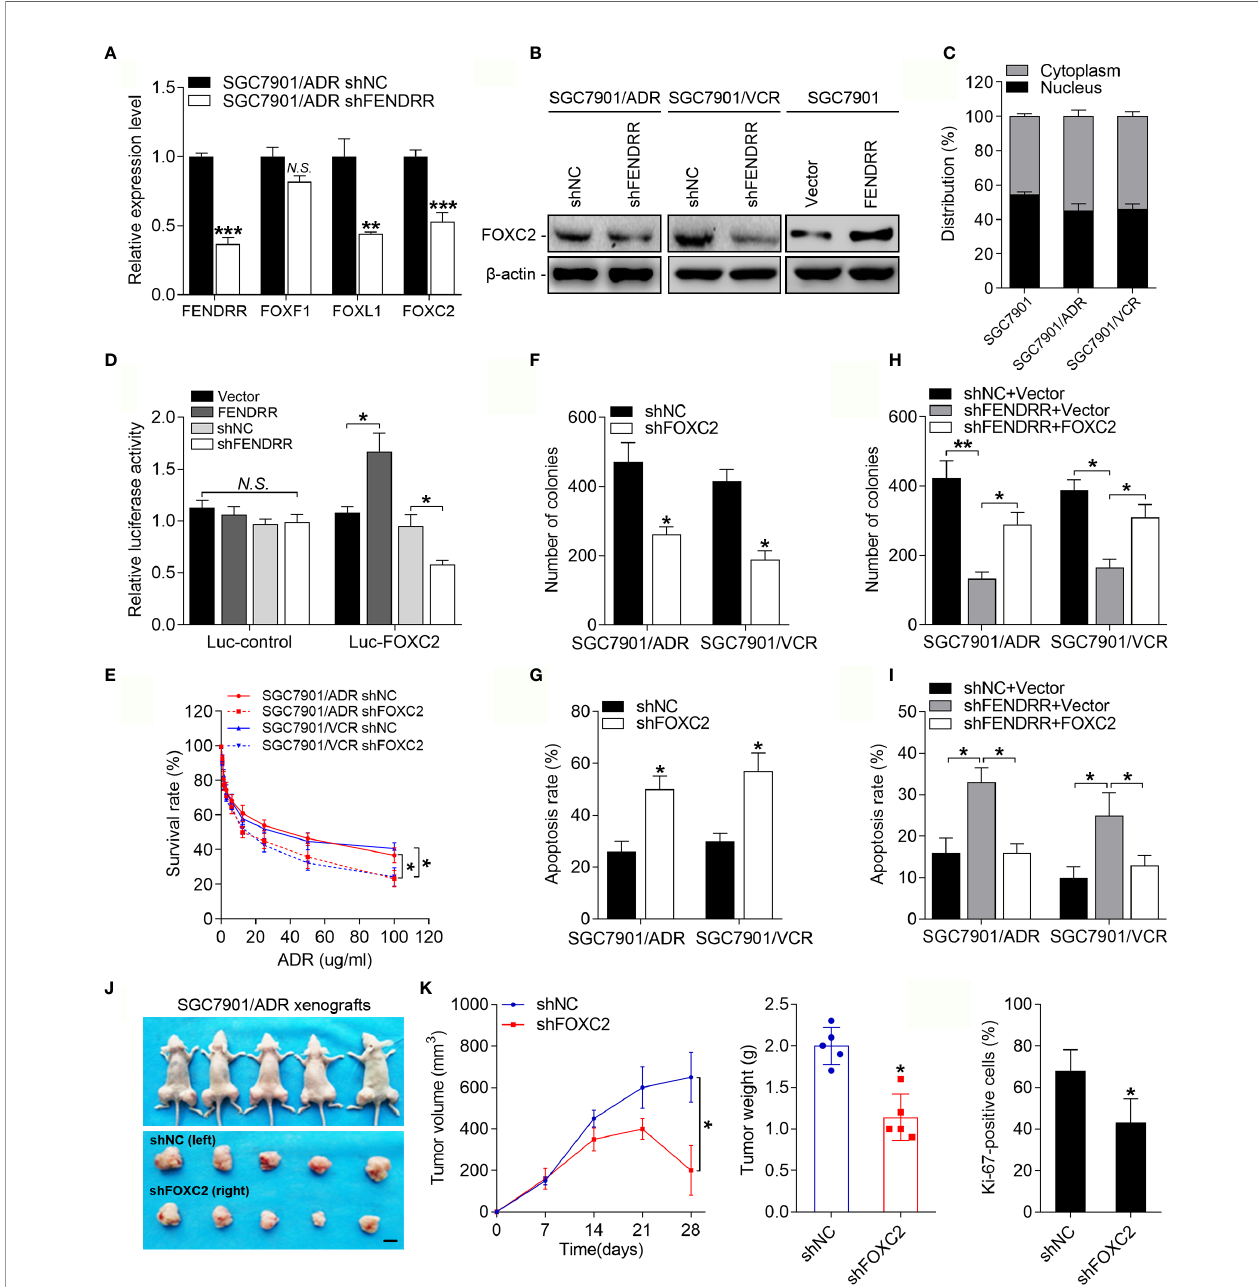
FIGURE 3 | FENDRR-regulated FOXC2 overexpression promotes GC drug resistance (A) qRT-PCR analysis of FENDRR, FOXF1, FOXL1 and FOXC2 expression in SGC7901/ADR cells infected with FENDRR shRNA or negative controls. (B) Western blot analysis of FOXC2 expression in SGC7901/ADR and SGC7901/VCR cells infected with FENDRR shRNA and in SGC7901 cells transfected with FENDRR vectors and the corresponding negative controls. (C) Expression levels of FENDRR in the nucleus and cytoplasm of the indicated cells was measured by qPCR. U1 and GAPDH were used as nuclear and cytoplasmic controls, respectively. (D) HEK- 293 cells were transfected with FOXC2 luciferase reporter constructs and FENDRR-expressing vectors or shRNA and the corresponding negative controls. Luciferase activity values were measured and analyzed. Luciferase values are normalized to empty vector control values. (E) Survival of indicated cells after step-up concentration of ADR treatment for 72 h was evaluated using the CCK-8 assay. (F, G) Colony formation assay with the indicated cells treated with ADR (F) and the apoptotic rate of the indicated cells treated with 5-FU (G) are shown. (H, I) Colony formation assay (H) and apoptosis assay (I) of SGC7901/ADR and SGC7901/ VCR cells infected with LV-shFENDRR with FOXC2 vector or control vector after ADR and 5-FU treatment, respectively. (J) LV-shFOXC2-infected cells were transplanted into the right fl ank of nude mice, and the corresponding control cells were transplanted into the left side. Left, representative images of tumors formed in nude mice (n=5) after ADR treatment are shown, scale bar, 1 cm. Middle, the tumor volumes of different groups were measured at the indicated time points. Right, the tumor weights of different groups measured after tumor isolation. (K) Quanti fi cation of the Ki67-positive staining of cells in xenografts from nude mice. ** P < 0.01, * P < 0.05, N.S. , not signi fi cant ( P > 0.05), error bars,